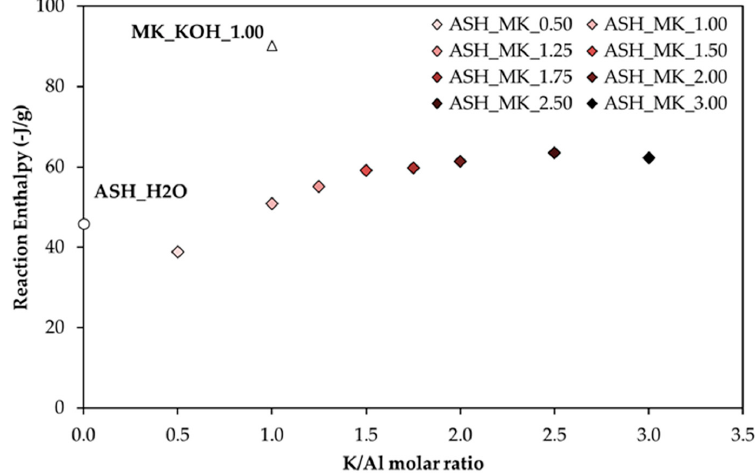
/ Al molar ratio and reaction enthalpy of mixtures after 60 h of Figure 6. Relation between K/Al molar ratio and reaction enthalpy of mixtures after 60 h of testing. Figure 6. Relation between K